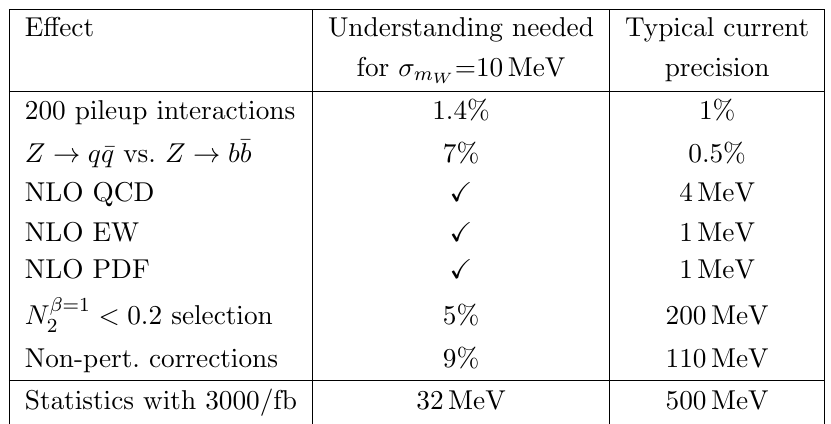
Table 6 . Summary of uncertainties for an m Z (cid:0) m W measurement. The understanding needed for (cid:27) m = 10 MeV is the fraction of 10 MeV and the estimated size of e(cid:11)ect. It should be noted W that yet better precision is needed to achieve a sum in quadrature of all systematic uncertainties of (cid:27) m = 10 MeV. Unless stated otherwise a selection of p T > 300 GeV and N (cid:12) =1 W